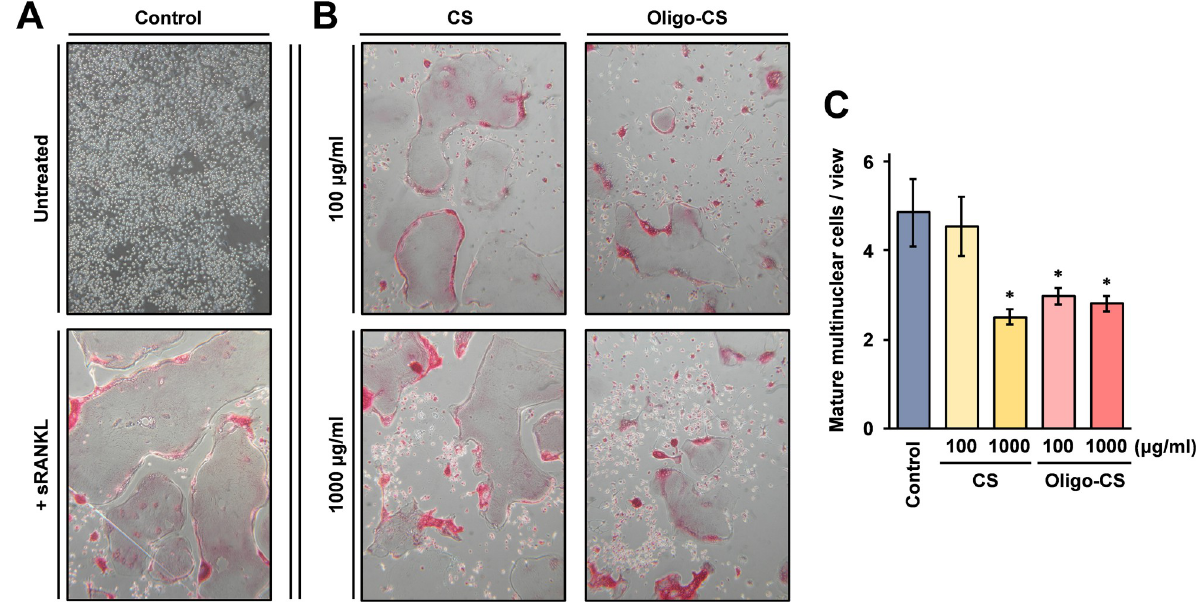
Fig 2. Oligo-CS effectively inhibits differentiation of RAW264 cells into osteoclasts. (A) RAW264 cells were grown in differentiation medium for 5 days to differentiate into osteoclasts. The control cells were grown in differentiation medium without sRANKL. Then the cells were subjected to TRAP staining. (B) RAW264 cells were grown in differentiation medium with the indicated concentrations of CS or Oligo-CS for 5 days, and the cells were subjected to TRAP staining. (C) The TRAP positive mature multinuclear cells were counted under a microscope. Error bars indicate standard deviations calculated from at least 19 frames of each group. Asterisks ( * ) shown in the graph indicate that the difference is statistically significant ( p < 0.05) compared to the control.